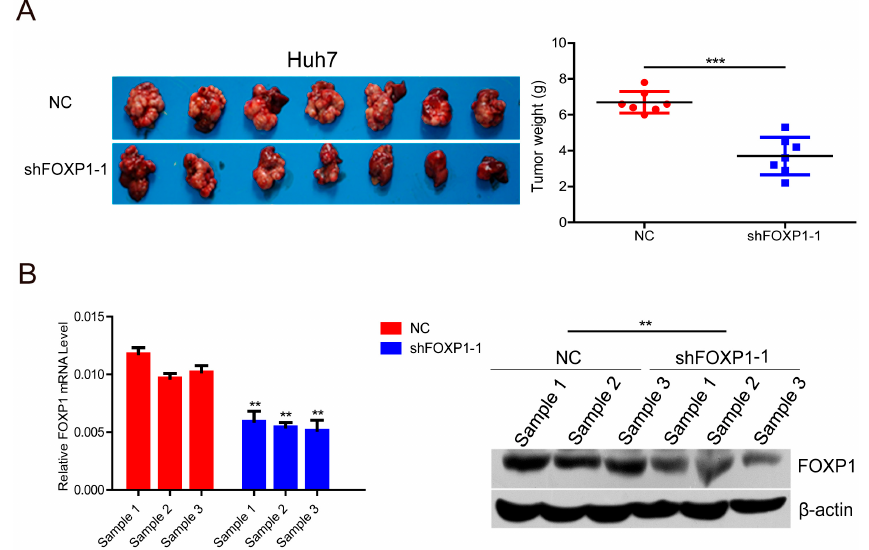
Figure 3. The effect of FOXP1 on the tumorigenicity of HCC cells in vivo. ( A ) Huh7 cells stably expressing shFOXP1-1 were injected orthotopically into nude mice; empty vectors were used as a control. The tumors were removed from the nude mice after four weeks. Representative images are shown along with the weight of the livers with tumors. ** p < 0.01; *** p < 0.001; ( B ) FOXP1 mRNA and protein levels in the xenograft tumors. ** p < 0.01